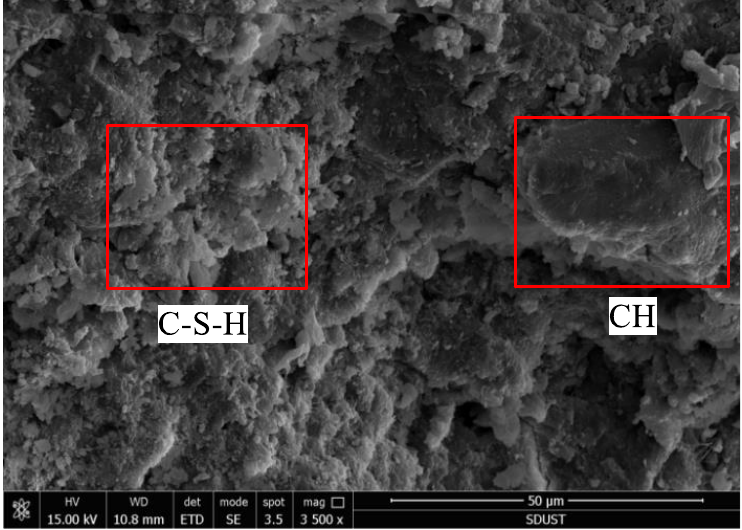
Figure 5. SEM image showing typical microstructure of backfill.